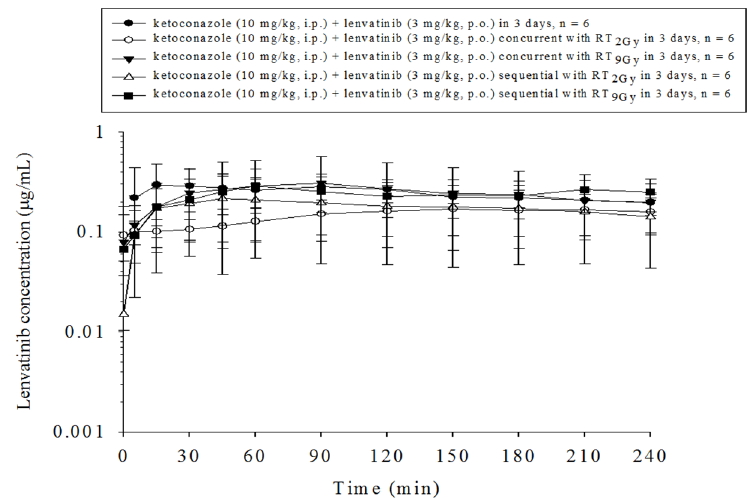
Figure 4. The concentration–time curves of lenvatinib in the plasma of rats that received lenvatinib coadministered with ketoconazole with or without radiotherapy (RT) under different time courses. Data are expressed as the mean ± standard error of the mean ( n = 6 per group).